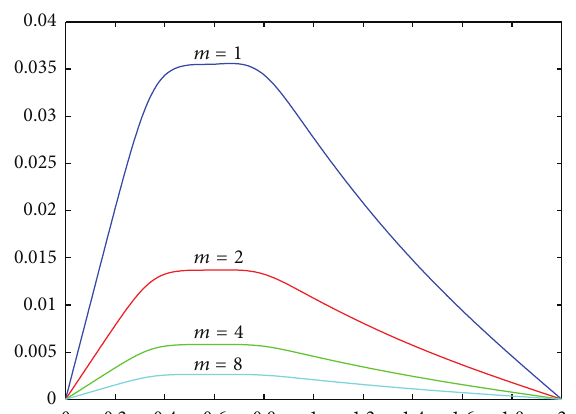
Figure 4: Error |𝑐 − 𝐶| when 𝑡 = 0.5 .